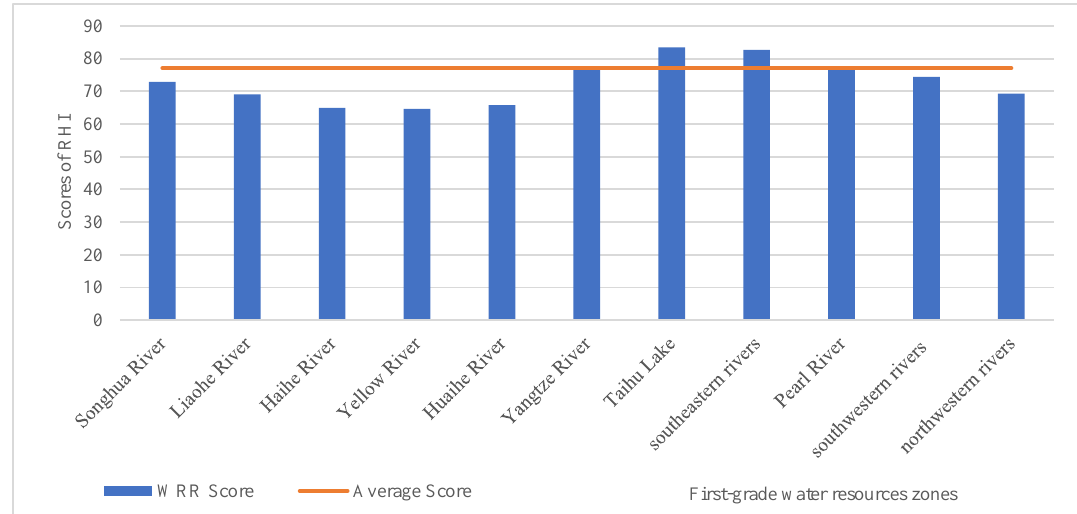
11 of 20 Figure 3. FCC evaluation results for China’s first -grade water resource zones. 4.2. Water Resources Reliability (WRR) WRR scores 77.1 points nationwide, which is generally at a medium level. The overall water resource reliability nationwide is: AWP stands at a medium-high level against the international warning line for water shortage, WSR is at a good level, and WUR is well below 40%, but water resources are unevenly distributed across regions, which is incom- patible with population distribution and allocation of productive forces; the level of water conservancy is yet to be further improved, and there is a clear gap in GDP Output per cubic meter of Water use (GOW) compared with high-income countries; and CSD is gen- erally at a medium-low level. Continuing to play the basic role of happy rivers and lakes